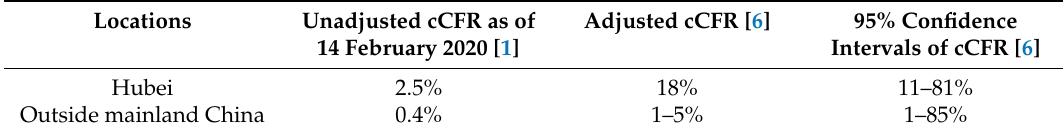
Table 1. Confirmed case fatality risk (cCFR) with and without adjustment of the time from illness onset to